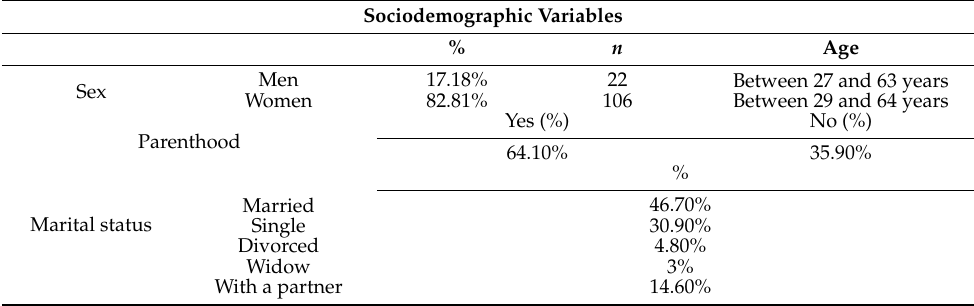
Table 1. Distribution of sociodemographic variables.